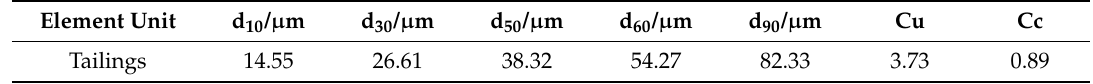
Table 1. Physical properties of the materials.